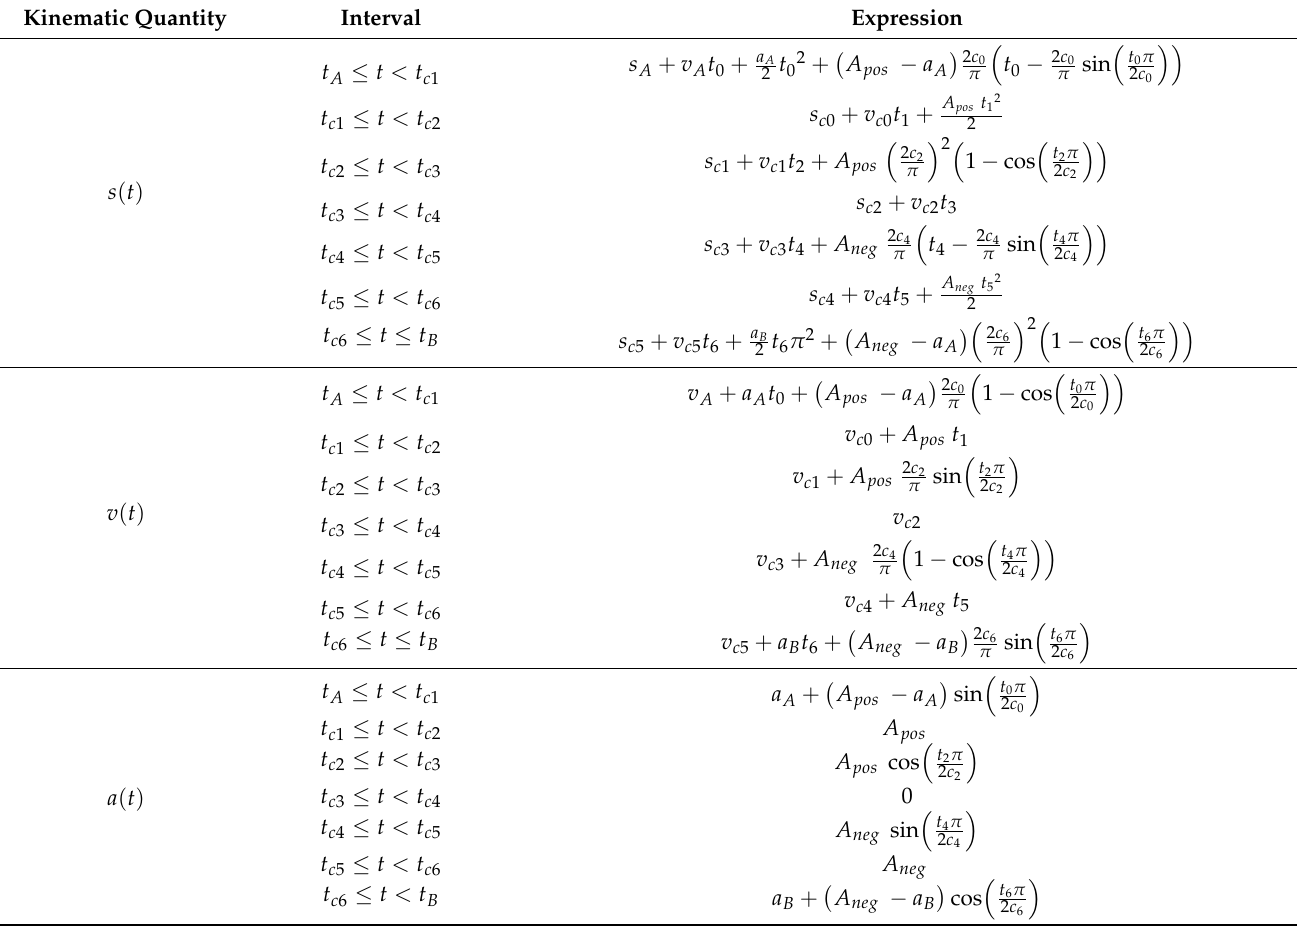
Table A2. Analytic expression of displacement, velocity and acceleration at time t of a trapezoidal modified law of motion in the most general